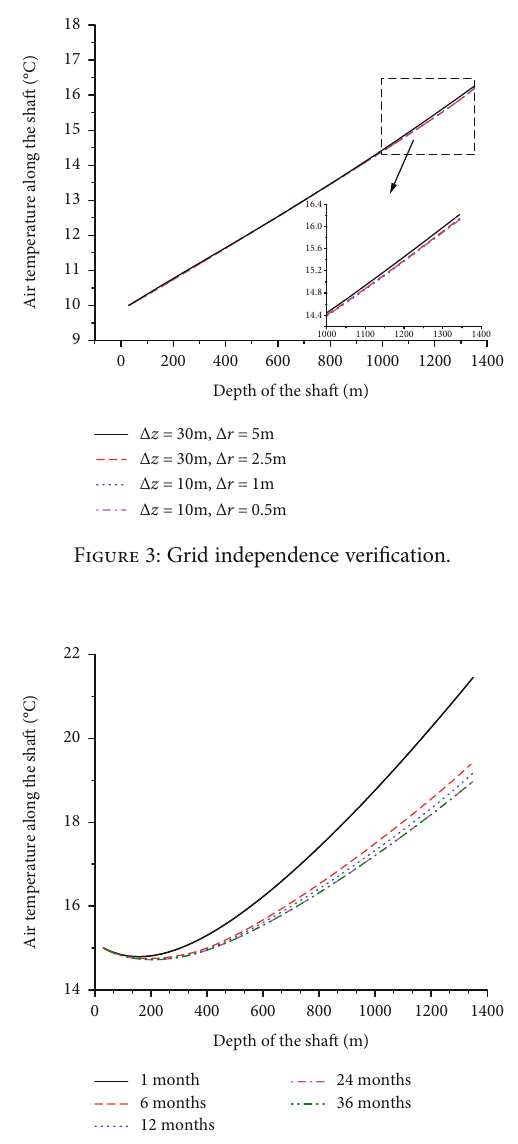
Figure 4: The variation of the air temperature along the shaft with the ventilation